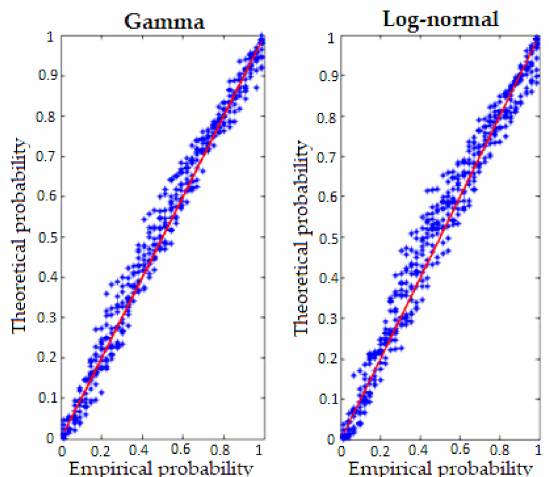
Figure 5. Comparison of theoretical and empirical probabilities; Gamma and log-normal distribution fitted to monthly rainfall and runo ff data, respectively, for the Rasht Basin.